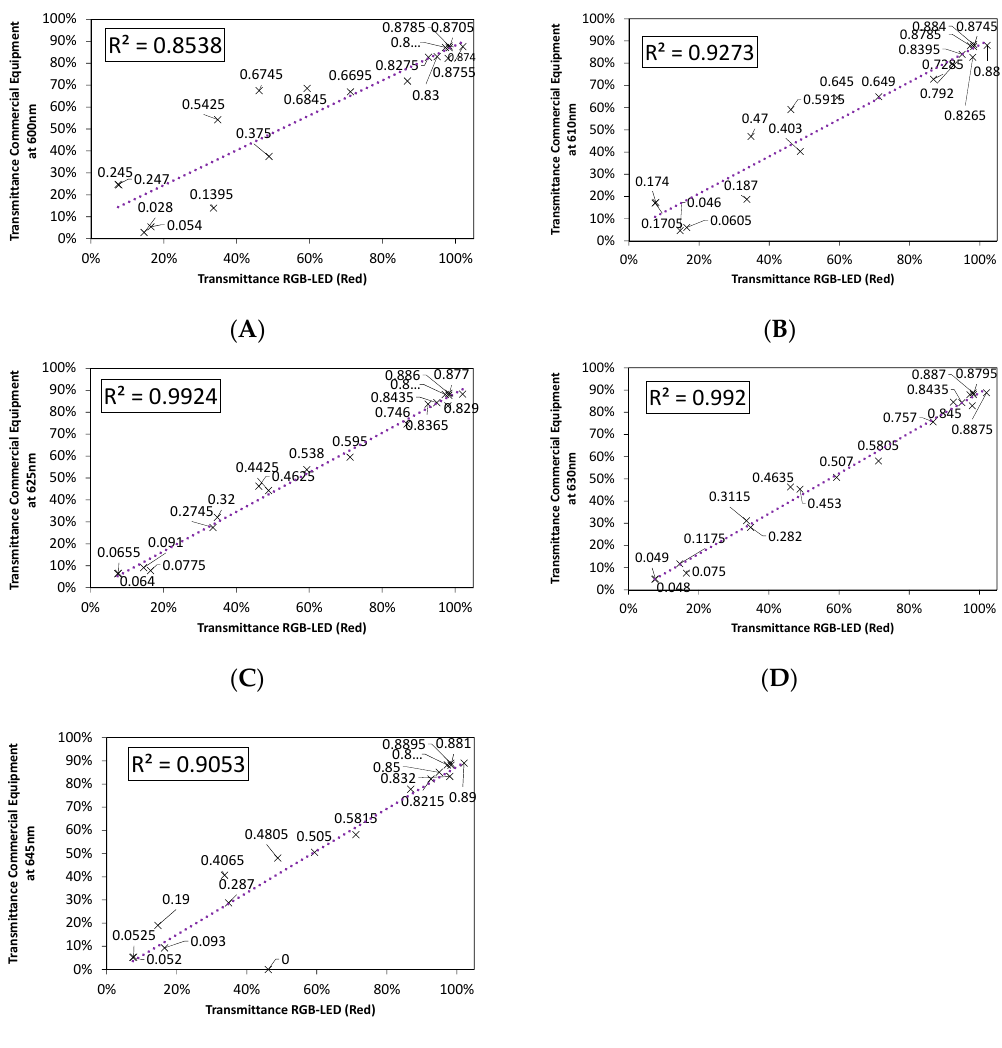
9 of 27 Figure 7. Comparative transmittance values by the blue LED and incandescent lamp at 460 nm. At this point, it is key to determine how the effect of the remaining wavelengths can be eliminated, without using filters or diffraction grids. Our investigations concluded that there is a linear relation between the transmittance values provided by the RGB-LED when it uses each of its LEDs (red, green, and blue) independently, and those values that would be obtained with commercial equipment working at the same peak wavelength as the mentioned LEDs. However, not only can the peak length of each of the LEDs be calibrated but also all the wavelengths emitted by each of them (within a certain range). Nevertheless, we must take into account the fact that as the wavelength that we seek to model moves away from the peak wavelength of each LED, the accuracy of the model is reduced, so not all wavelengths can be successfully modelled. In order to determine which portion of the emission spectrum in each of the LEDs can be used